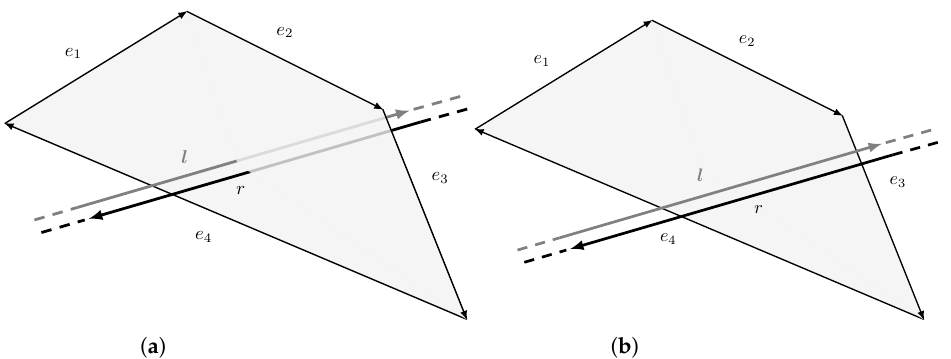
Figure 9. ( a ) Lines stabbing a convex polygon in 3D space. Note that the line l goes counter-clockwise around all the edges e i , while r clockwise. ( b ) Lines missing a convex polygon in 3D space. Note that the line l goes counter-clockwise around the edges e 1 and e 4 , while clockwise around e 2 and e 3 . The opposite happens with r .